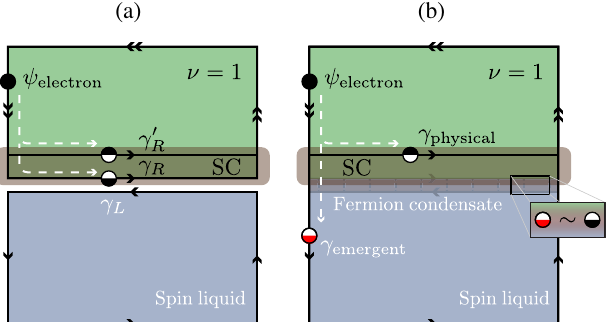
FIG. 7. (a) Interface between a non-Abelian spin liquid and a proximitized ν ¼ 1 integer quantum-Hall system. The bare ν ¼ 1 edge state — indicated by double arrows — generically separates into two copropagating Majorana fermions γ and γ 0 beneath the R R superconductor (SC) in the central region. (b) Strong interactions and the spin liquid ’ s edge Majorana fermion γ via can gap out γ R L formation of a fermion condensate that partially sews the two subsystems together. Physical Majorana fermions (black half- circles) and emergent Majorana fermions (red half-circles) are then identified at the interface; see enlargement for an illustration. A striking consequence follows: An electron injected at low energies into the ν ¼ 1 edge splinters into a pair of Majorana fermions, one of which unavoidably enters the spin